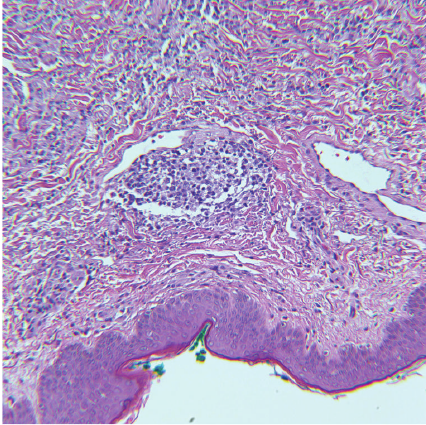
Figure 3: H&E section of skin biopsy showing a dense lympho- histiocytic dermal infiltrate composed predominantly of atypical lymphoid cells ranging in cell size